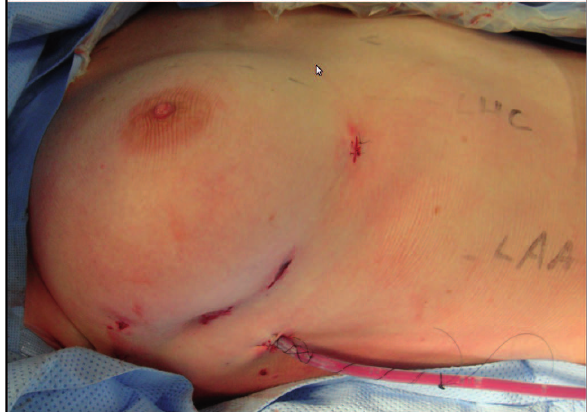
Fig. 3 - Aspecto cirúrgico final do campo